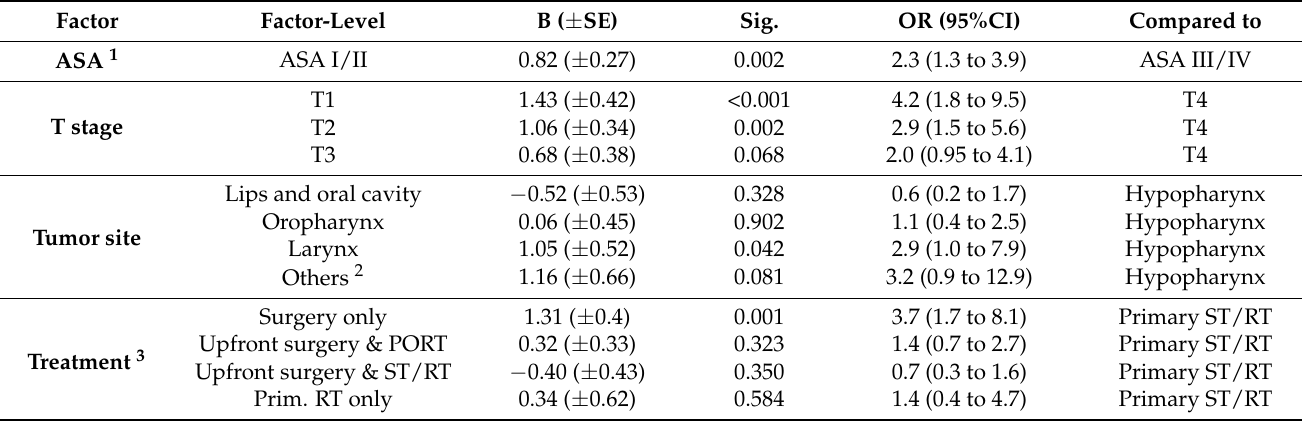
Table 3. Binary logistic model of factors influencing food intake in 427 patients with newly diagnosed HNC. Dependent variable was normal or near-normal food intake function (integrity score 3 and 4) vs. impaired food intake (integrity score 0–2). Factors with p values < 0.2 in Chi-square tests were included. Odds ratios (OR) indicate the chance to achieve normal or near normal food intake (the higher, the